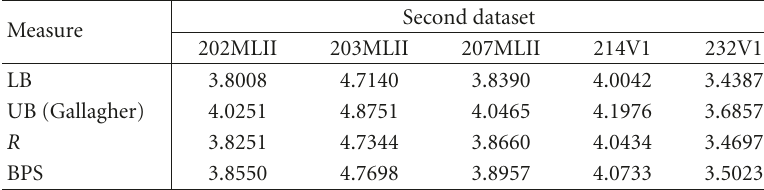
Table 4: SBT method: comparison between the theoretical bounds and the results obtained using Hu ff man encoder. Second Measure